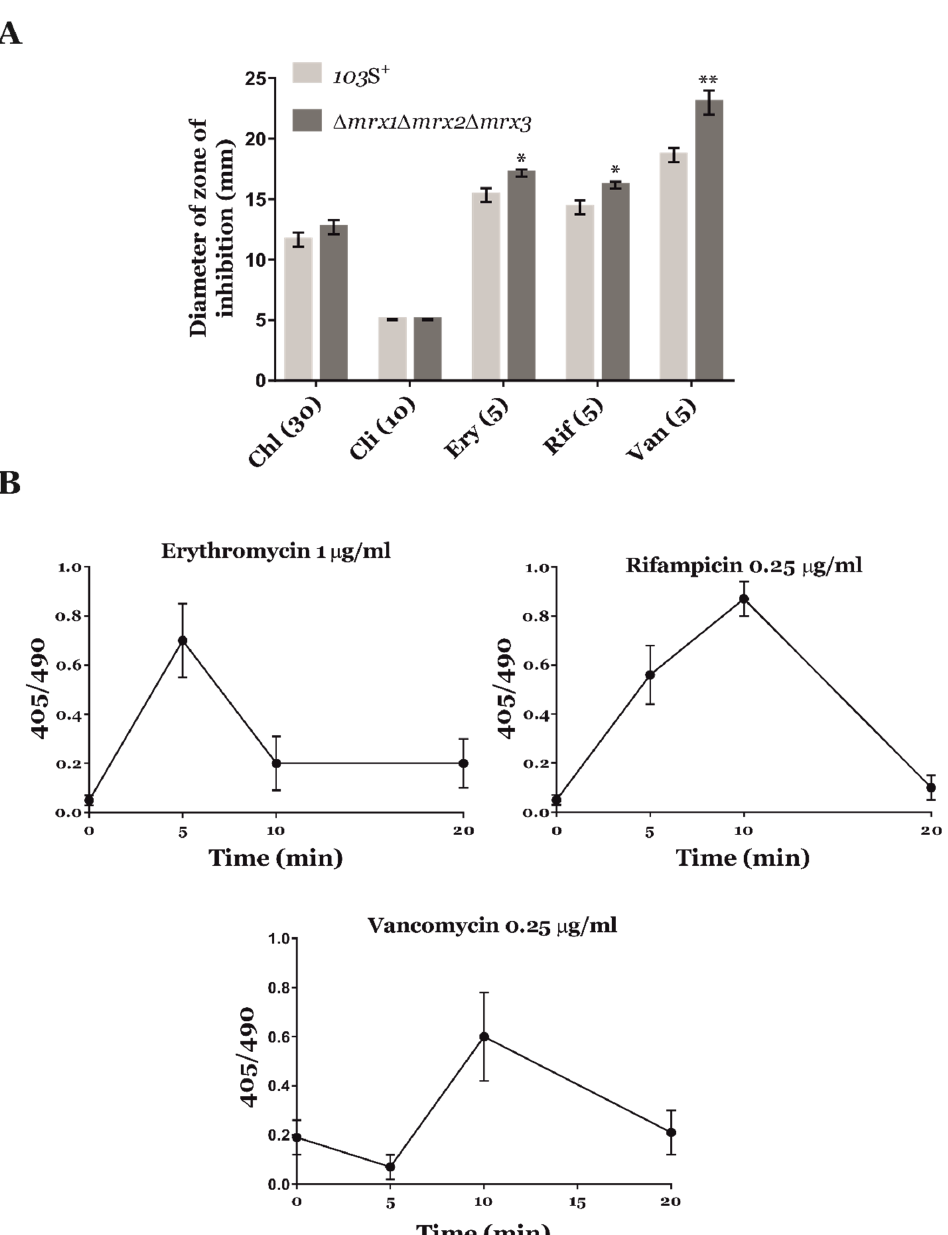
Figure 1. Screening results for the identification of ROS-generating antimicrobials active against R. equi . ( A ) Antimicrobial susceptibility of R. equi 103S + (clear grey) and R. equi ∆ mrx1 ∆ mrx2 ∆ mrx3 mutant (dark grey) to di ff erent antibacterial compounds: Chloramphenicol (Chl), clindamycin (Cli), erythromycin (Ery), rifampicin (Rif), and vancomycin (Van). The concentration used of each antibiotic is shown in brackets ( µ g / mL). The diameter of the growth inhibition zones was measured to the nearest millimetre, and the mean ± SD of three independent experiments was plotted. A Kruskall-Wallis non-parametric analysis was performed to test for statistical significance across comparisons of the wild type strain and the triple mrx -null mutant. p -value < 0.05 (*) or p -value < 0.01 (**). ( B ) Ratiometric response of the Mrx1-roGFP2 biosensor. Fluorescence 405 / 490 ratio was calculated by confocal microscopy at di ff erent time points in response to very low doses of rifampicin, erythromycin, and vancomycin. The results show the mean ± SD of three independent